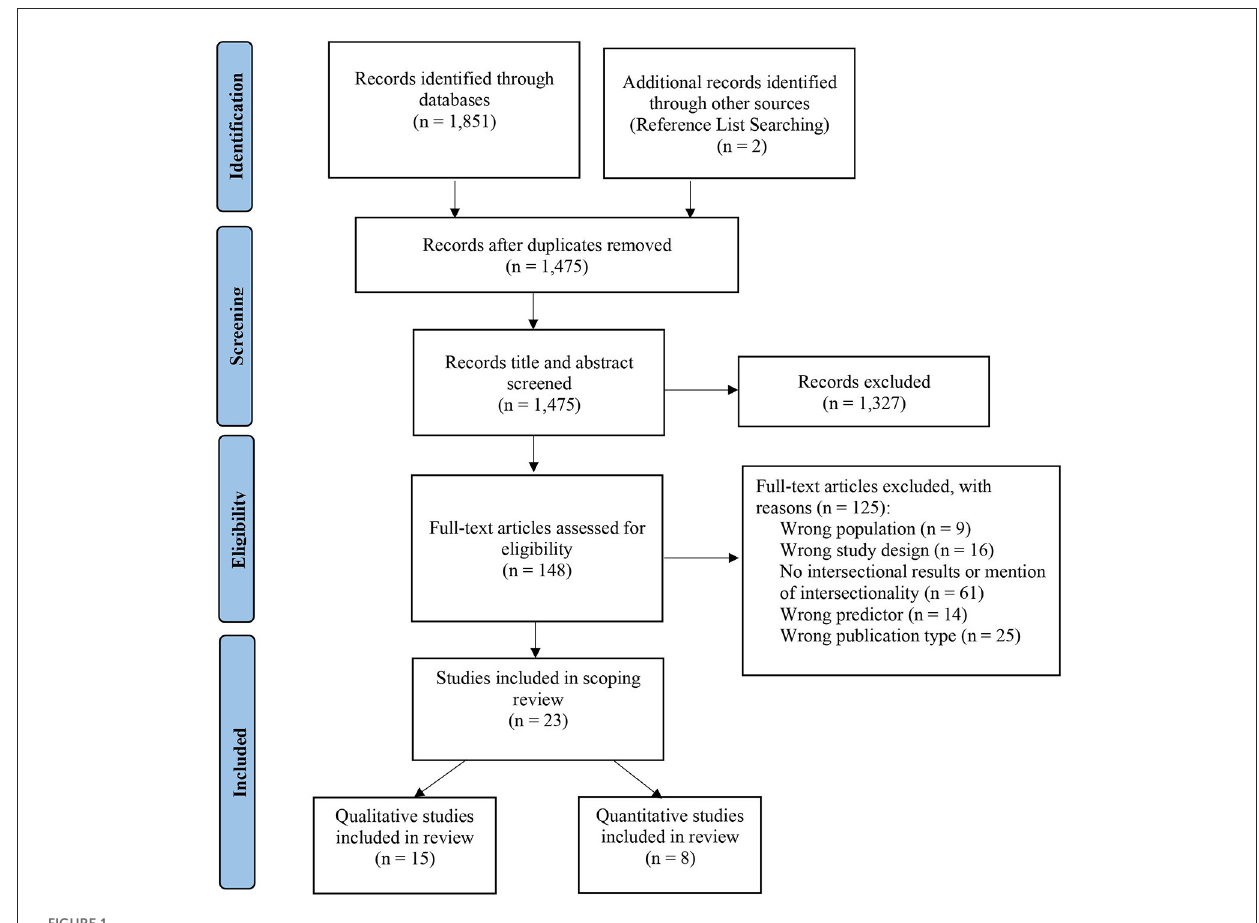
FIGURE1 Process of study selection using PRISMA